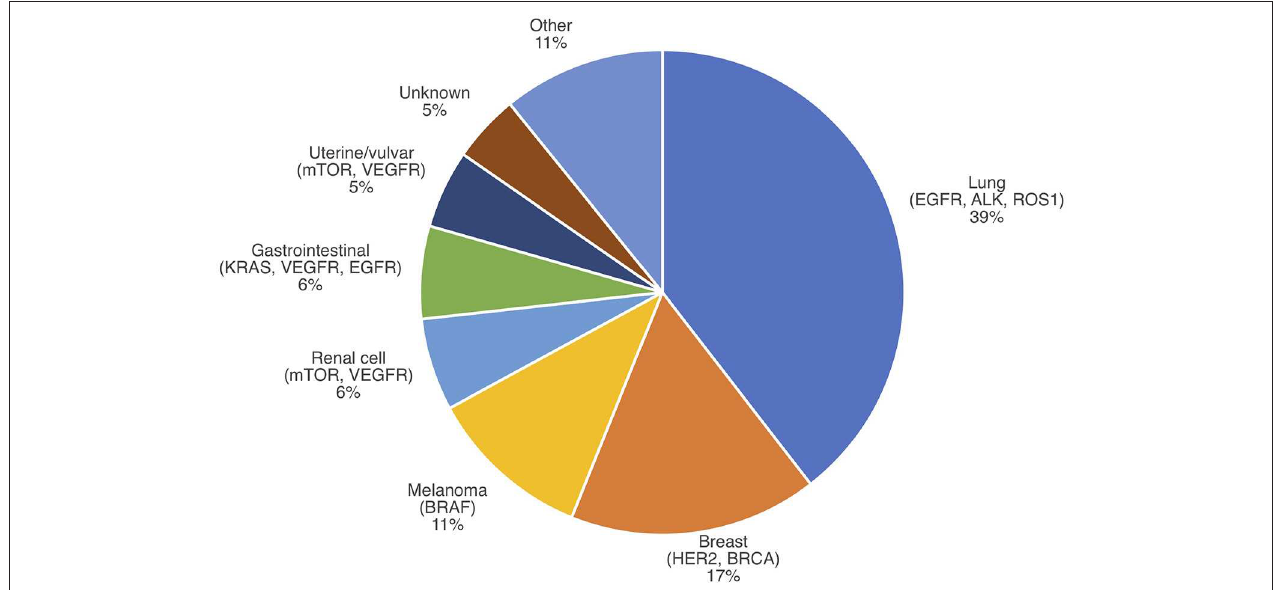
FIGURE 2 | IMD incidence by primary cancer type with select actionable mutations. Modified from Nussbaum et al.